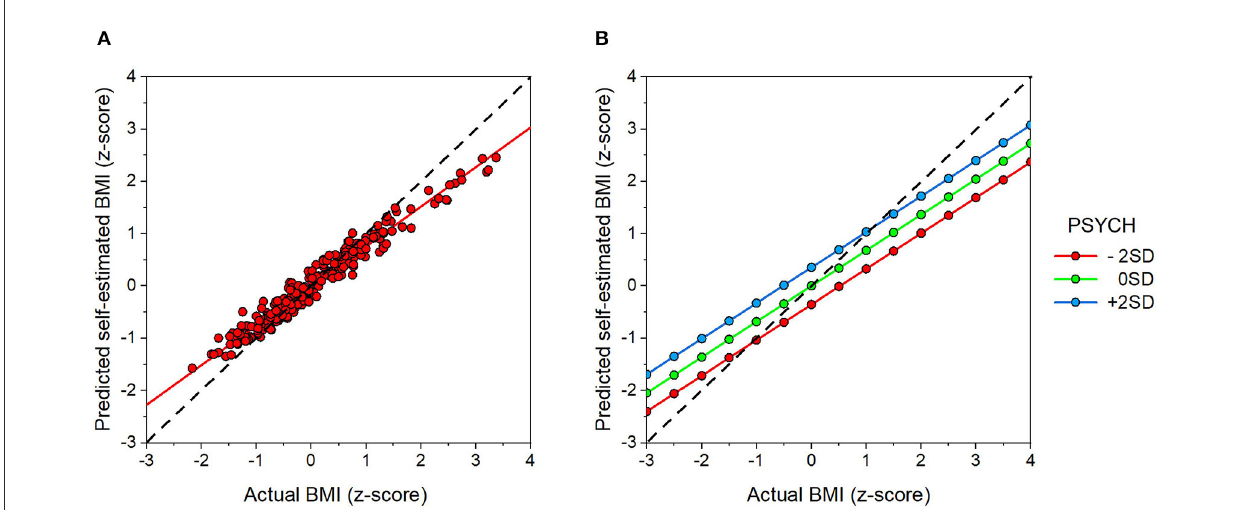
FIGURE3 (A) Shows a scatter plot of predicted self-estimated BMI, derived from the body composition that participants chose in the matrix task, plotted as a function of their self-reported actual BMI. Both sets of variables were centered prior to modeling. (B) Shows the independent effect of PSYCH (red = − 2sd, green = 0 sd, and blue = + 2sd) on the regression of self-estimated BMI as a function actual BMI. At any actual BMI, increased psychological distress about one’s body, indexed by increasing PSYCH scores, leads to an increase in self-estimated